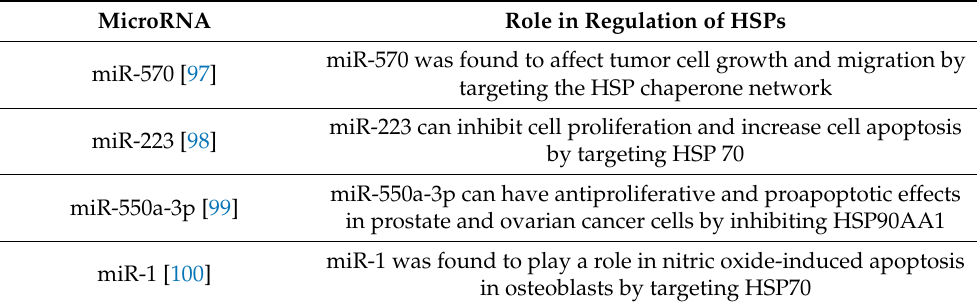
Table 2. A list of possible microRNAs and their role in the regulation of HSPs. These microRNAs may act as potential treatment options for modulating the activity of HSPs to yield favorable results in women with